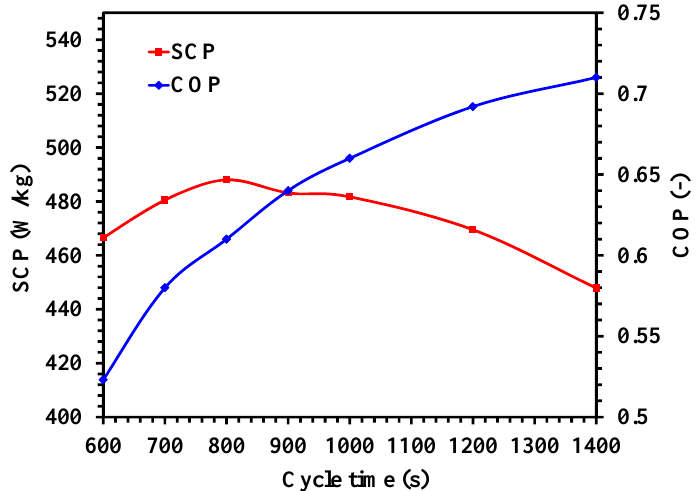
Figure 11. The variation of coefficient of performance (COP) and specific cooling power (SCP) with cycle time.